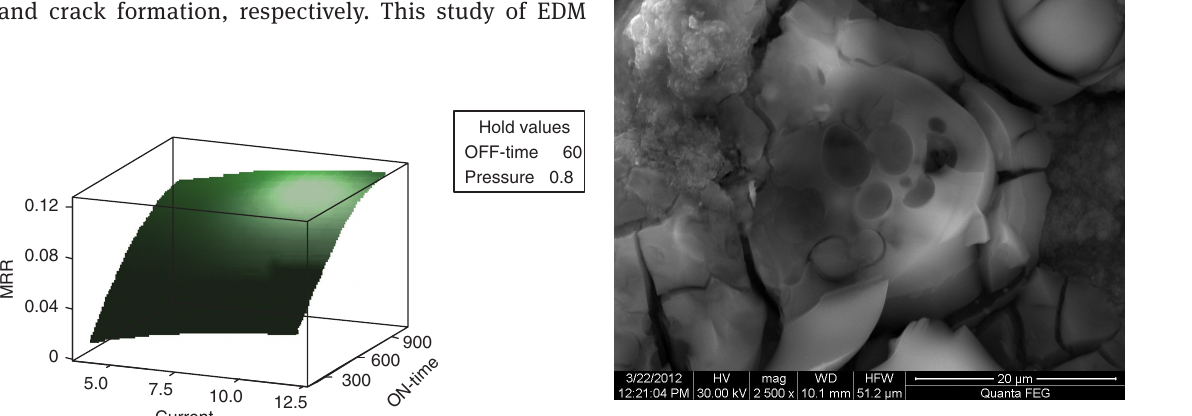
Figure 8 Surface plot of MRR vs. on time, current.